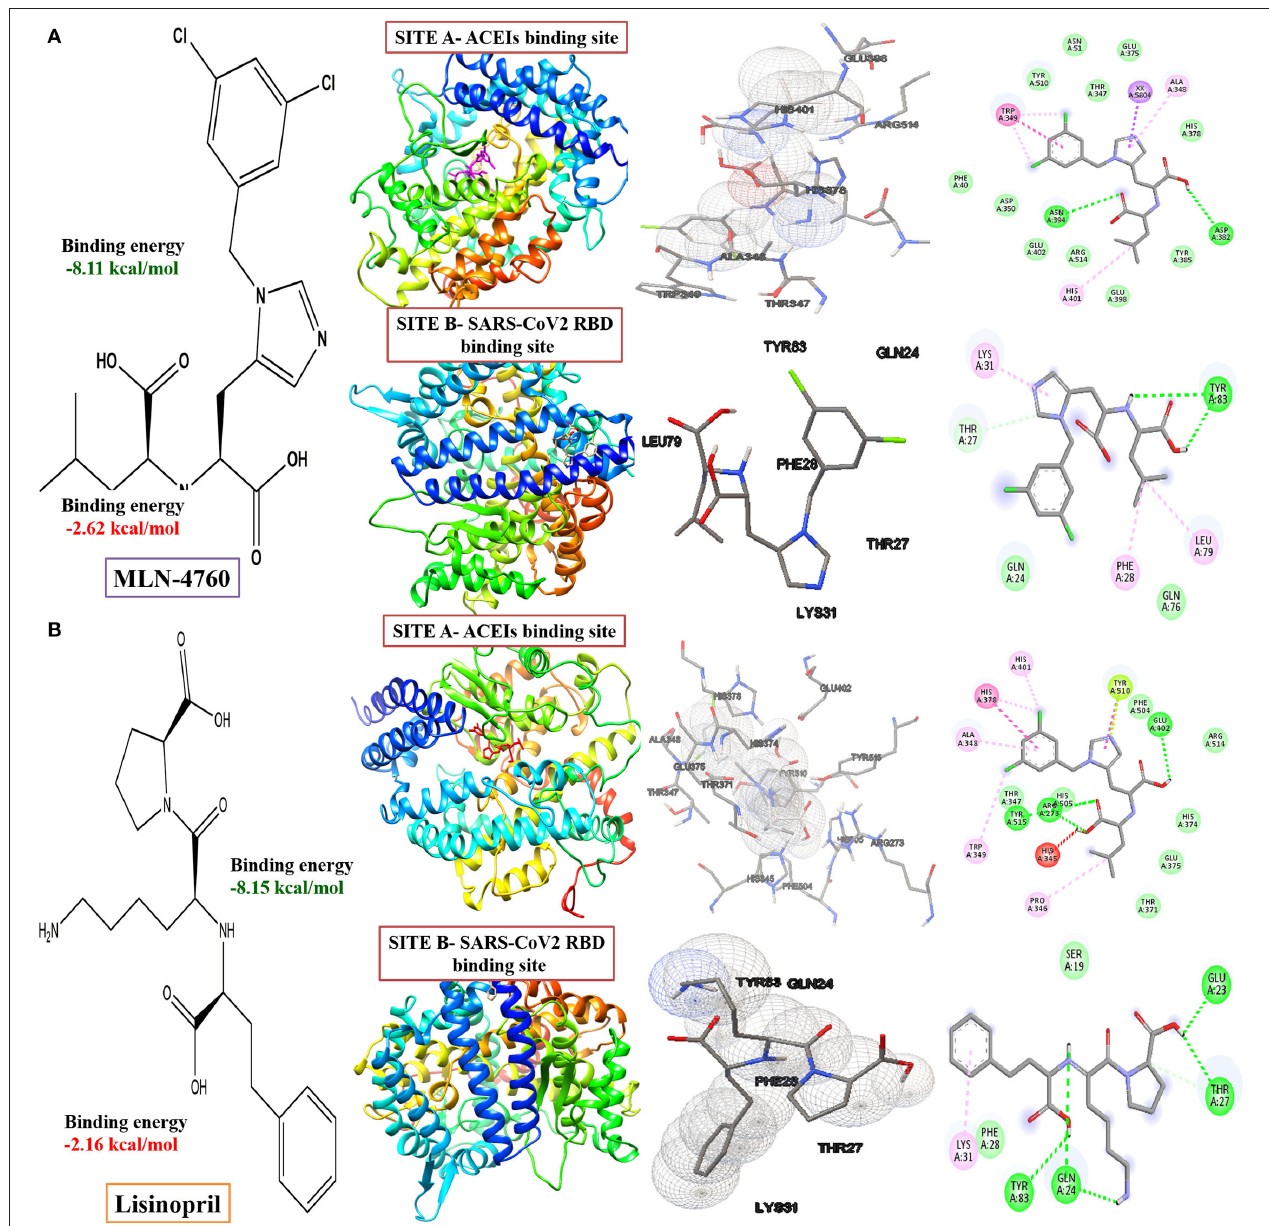
FIGURE 7 | Computed structural comparison, binding features, and the 2D interaction plot (visualization using UCSF Chimera, AutoDock and Biovia discovery studio) of MLN-4760 ((S,S)-2-{1-carboxy-2-[3-(3,5-dichlorobenzyl)-3H-imidazol4-yl]-ethylamino-4 methylpentanoic acid) (A) and lisinopril (B) , with two binding sites of the ACE-2 receptor (PDB ID: 1R4L and 6M0J,